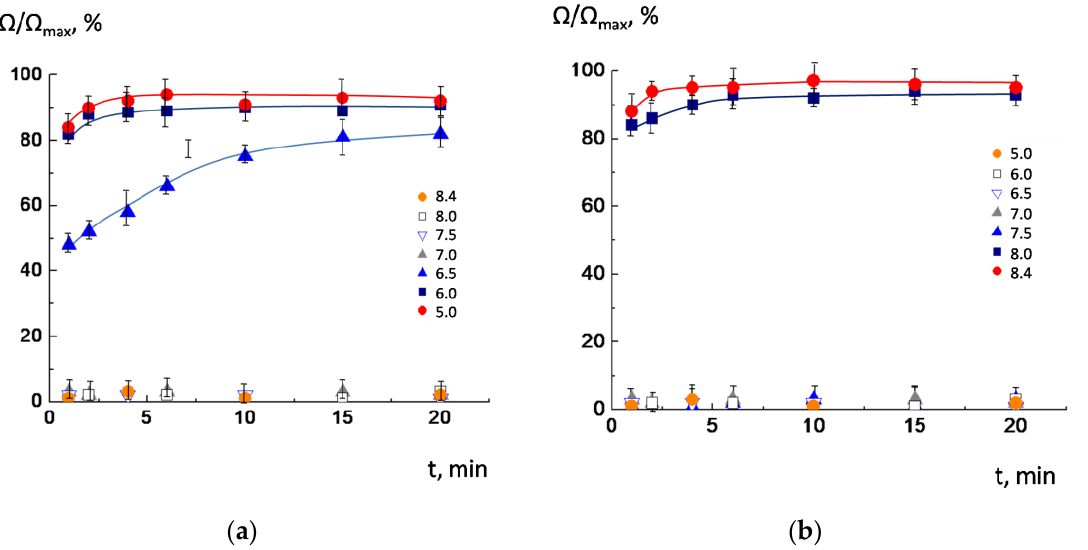
Figure 3. Time-dependent changes in the relative electrical conductivity of NaCl-loaded POPC/AMS liposomes at different pH values. Liposomes were prepared at pH = 8.4 ( a ) and at pH = 5.0 ( b ) and then transferred to buffers with different pH. Lipid concentration 1 mg/mL . α AMS = 0.1.